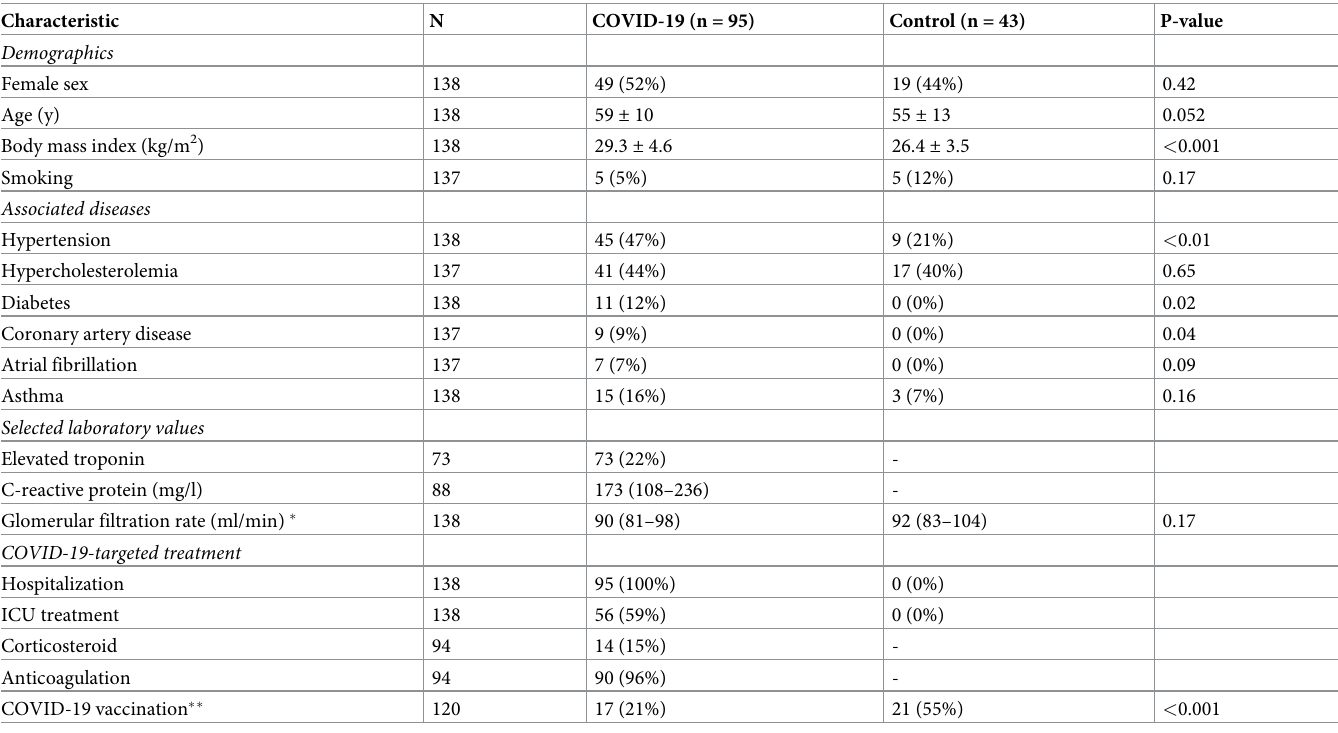
Table 1. Clinical characteristics of COVID-19 patients and control group during the initial